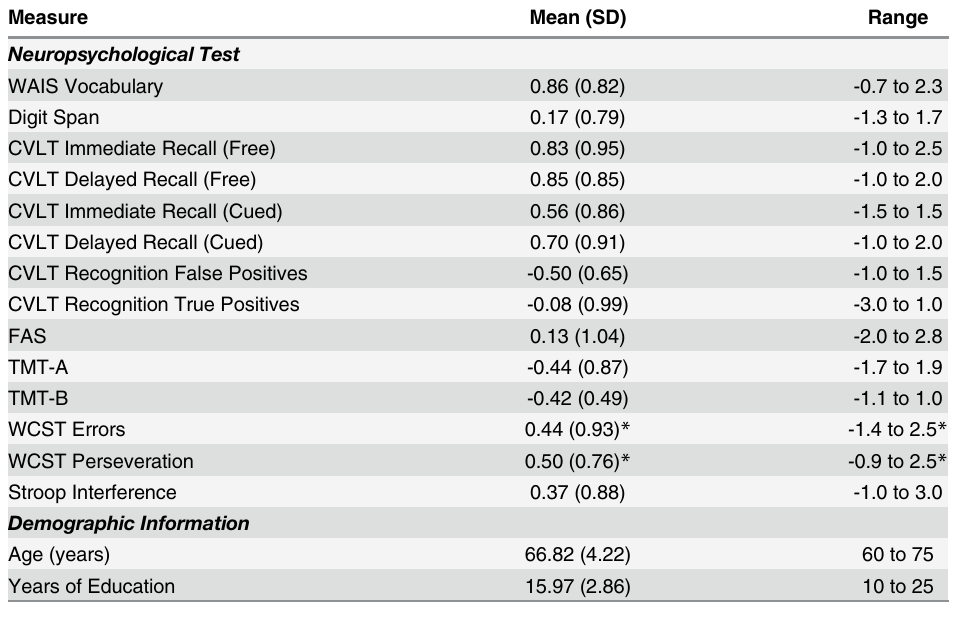
Table 1. Neuropsychological test results and demographic information for older